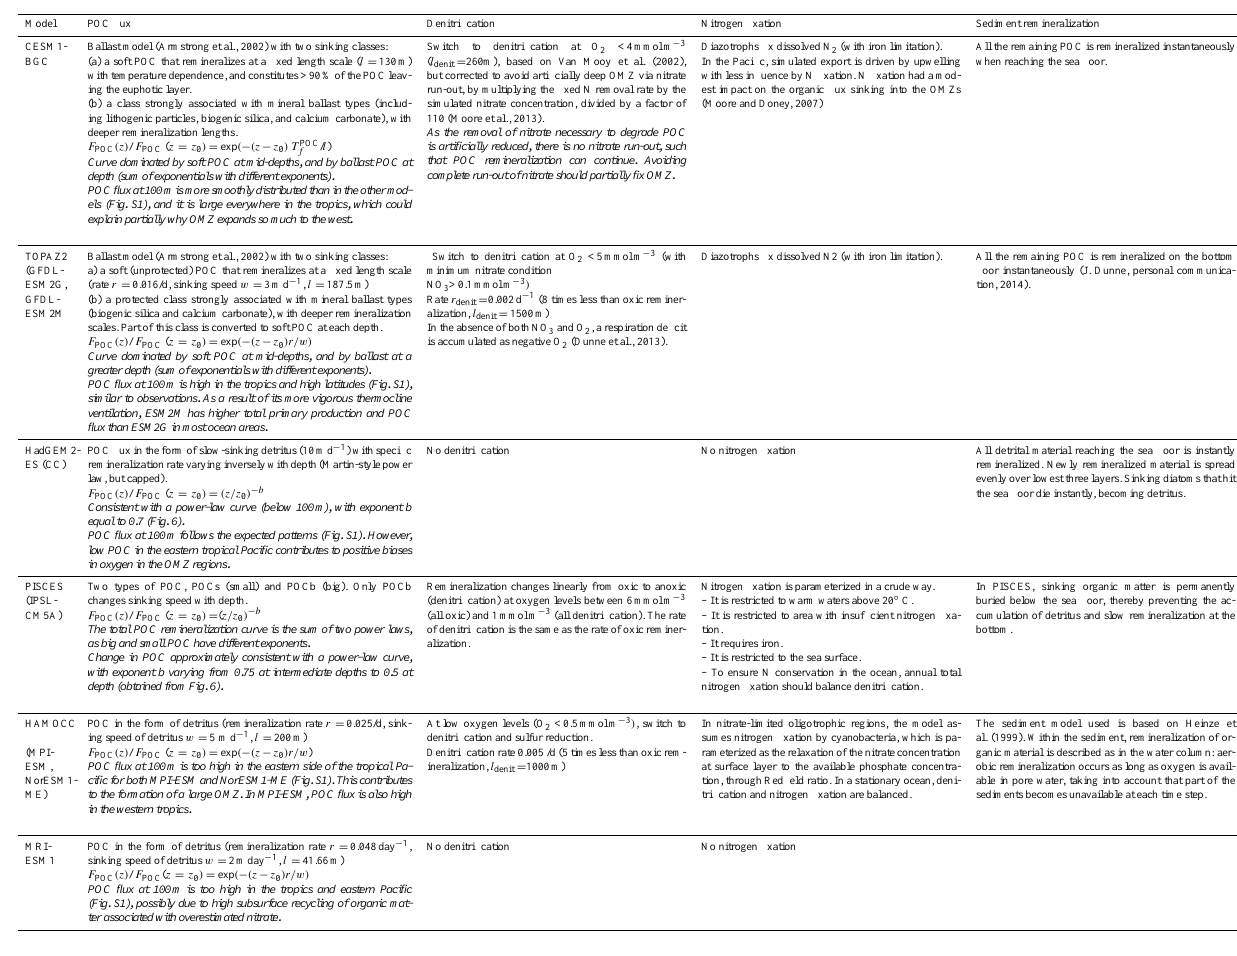
Table A3. Description of biological parameters that might affect OMZ extension, including POC flux profile, denitrification, nitrogen fixation, and sediment burial across CMIP5 models, summarized from references in Table A1, and our analysis (see also Fig. S1). Most CMIP5 biogeochemical models use a constant rate of remineralization r combined with a constant sinking speed of POC or a sinking speed increasing with depth. In the case of linearly increasing sinking speed w(z) = w o + a · z and the POC flux profile ( F POC ) follows a classical Martin power-law curve F POC (z) = F POC ( z 0 ) ( z/z 0 ) − b , with b equal to r/a . In the constant sinking speed case, the POC flux profile follows